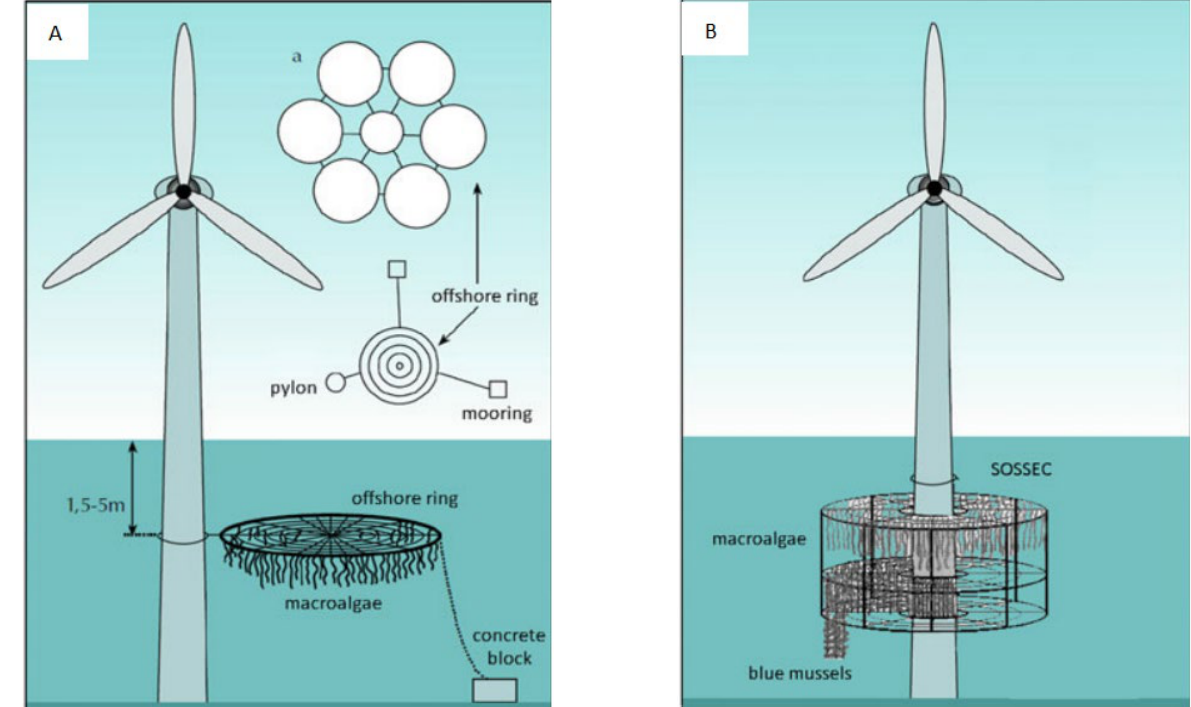
Figure 24. Integrated aquaculture—wind turbine. ( A ) Ring system, ( B ) Integrated mussel-seaweed system [56].